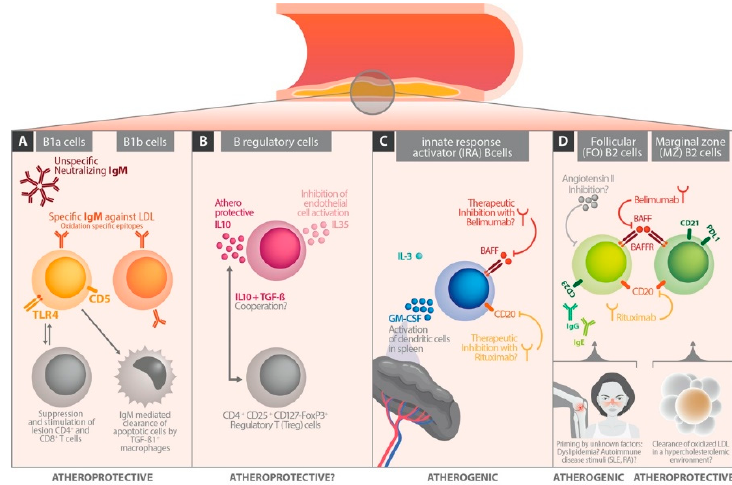
Figure 1. Different B cell subsets found in atherosclerotic lesions of murine models. ( A ) B1a and B1b cells act atheroprotective by production of IgM antibodies against oxidation-specific epitopes. Toll like receptor 4 (TLR4) expressing B1a cells suppress CD4 and CD8 T cells in AS lesions, and increase the TGF- β 1 expression on lesion macrophages. TGF-ß1 positive macrophages participate in IgM mediated clearance of apoptotic cells. ( B ) Regulatory B cells act also atheroprotective by secreting IL-10 that influences T regulatory cells. T cell growth factor ß may be involved in this process. IL-35 secretion inhibits mitochondrial reactive oxygen species mediated activation of endothelial cells. ( C ) Innate response activator B cells act atherogenic by producing high amounts of granulocyte–macrophage colony-stimulating factor that activates dendritic cells in spleen. ( D ) The B2 cells form in the spleen and lymph nodes the the follicular (FO) and marginal zone (MZ) B2 cell population. The (FO)B2 cells may act proatherogenic depending on the state of inflammation and the local inflammatory microenvironment (e.g., autoimmune diseases, dyslipidemia). Angiotensin II may influence (inhibit) the activity of (FO)B2 cells. The (MZ)B2 cells are involved in the cholesterol metabolism and act atheroprotective by uptake of oxidized LDL in a hypercholesterolemic environment.